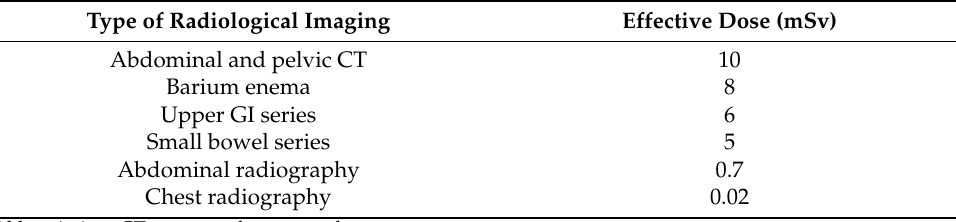
Table 1. The mean radiation dose for each typical radiological imaging type. Type of Radiological